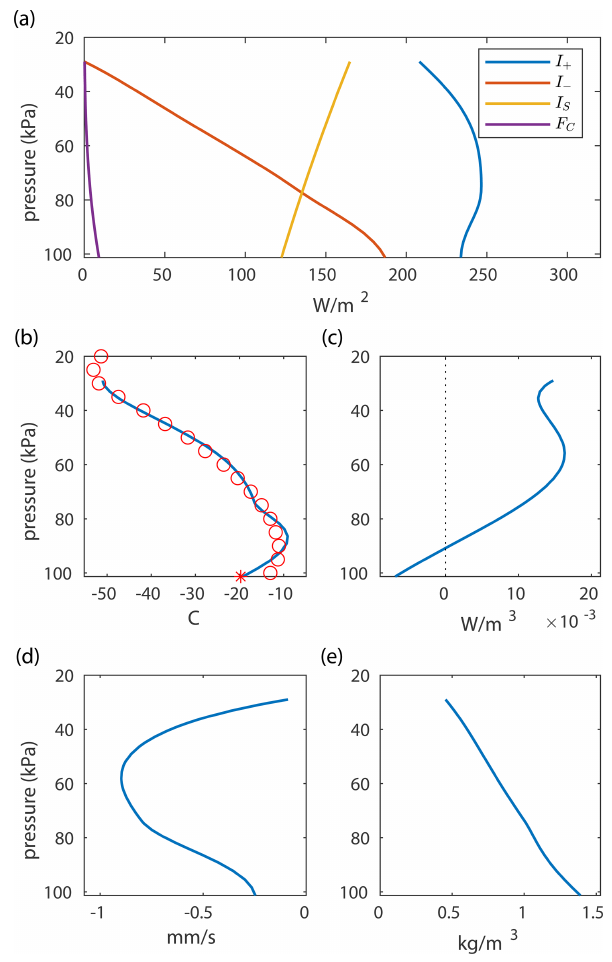
Figure 3. Results of the fully calibrated Arctic model at µ = 390ppm. The vertical axis in all the plots is the pressure. (a) En- ergy transport via radiative terms, and latent and sensible heat. (b) Temperature of the atmosphere. The red circles are the data from Cronin and Jansen (2016). The red asterisk is the surface temper- ature, T S . (c) Atmospheric heat transport, F A . (d) Vertical wind speed. (e)